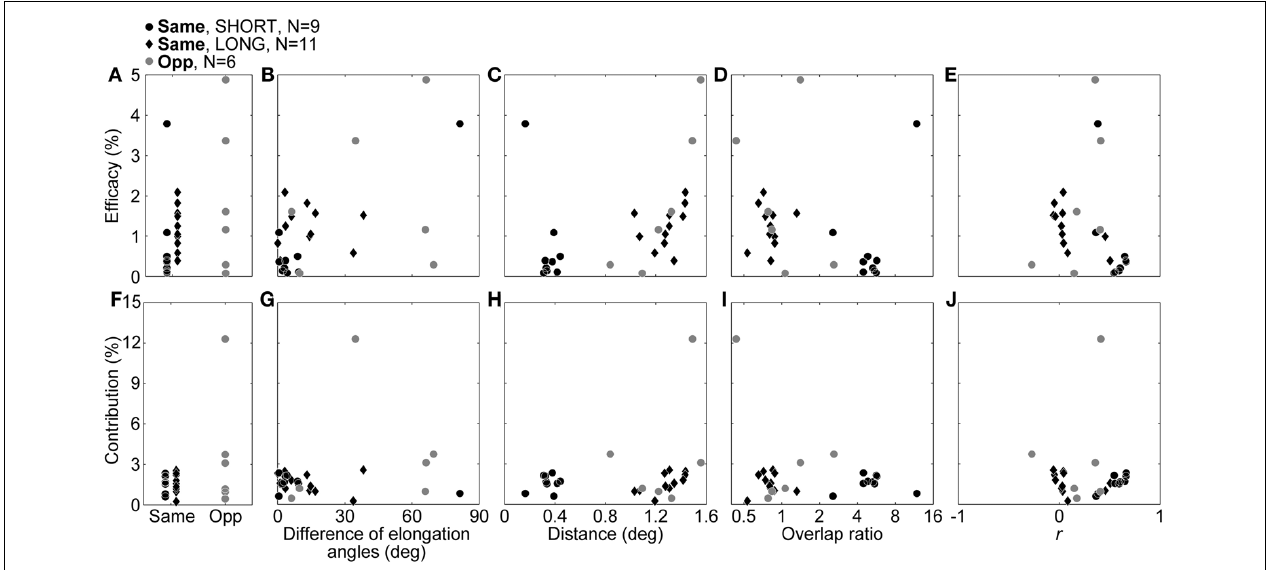
FIGURE 6 | Efficacy and contribution, and the correlations with RF properties. In the upper row, the efficacy itself (A) , correlations with the difference of the elongation angles (B) , distance between RF center positions (C) , overlap ratio (D) , and correlation coefficient of the RF structures (E) , are shown. In the lower row, the contribution itself (F) ,